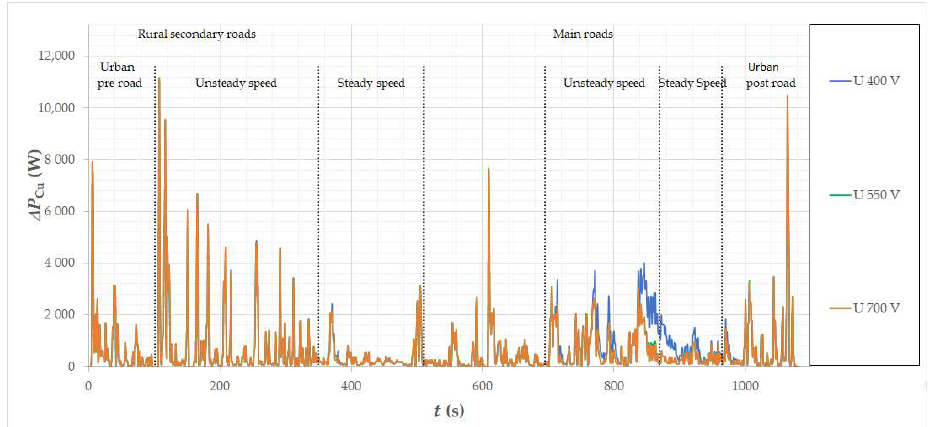
Figure 24. Calculated loss waveforms in the winding for the considered vehicle in the Artemis Road driving cycle.